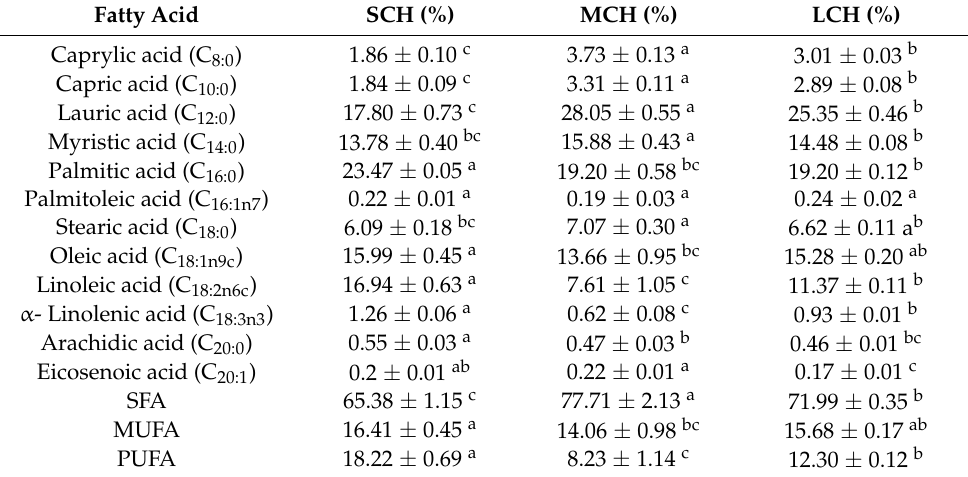
Table 2. Fatty acid composition of coconut haustorium 1